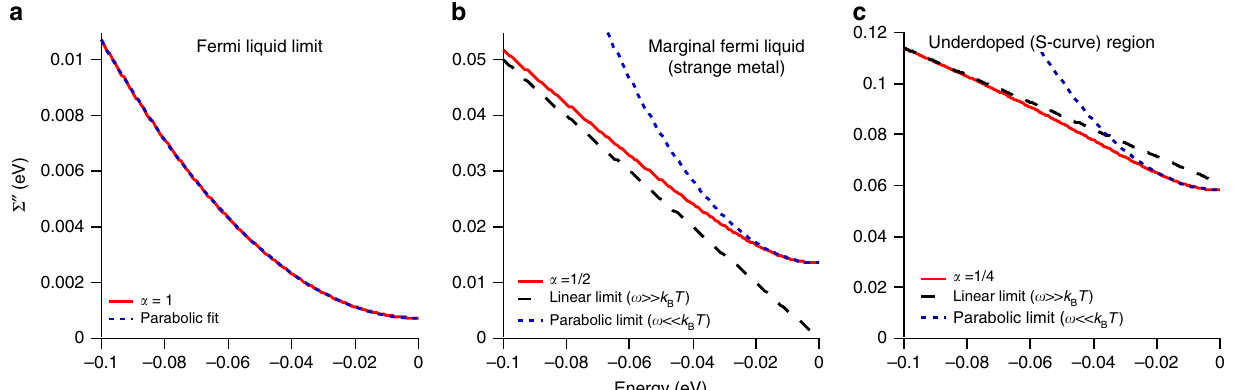
Fig. 3 Theoretical plots of the imaginary part of the self energy for different doping regimes (red curves) for T = 100 K, β = π , λ = 0.5 and Γ 0 = 0. a In the extreme heavily overdoped (HOD) case ( α = 1) the system behaves as a normal Fermi liquid with a ω 2 dependence. b In the optimally-doped case ( α = 0.5) the system can be approximated as having a ω 2 dependence at low ω and linear at high ω . c In the underdoped case ( α = 0.25) the system has an unusual s-curve ω dependence that shows a concave-up ω 2 dependence at low energies and a concave-down form at higher